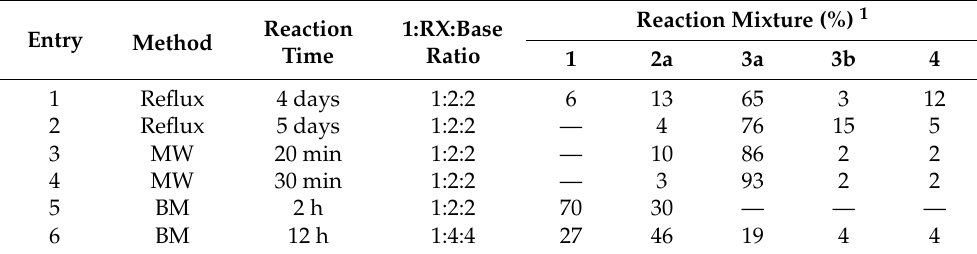
Table 1. Conditions and product percentages of reaction of 1 with Br(CH 2 ) 3 Pht.